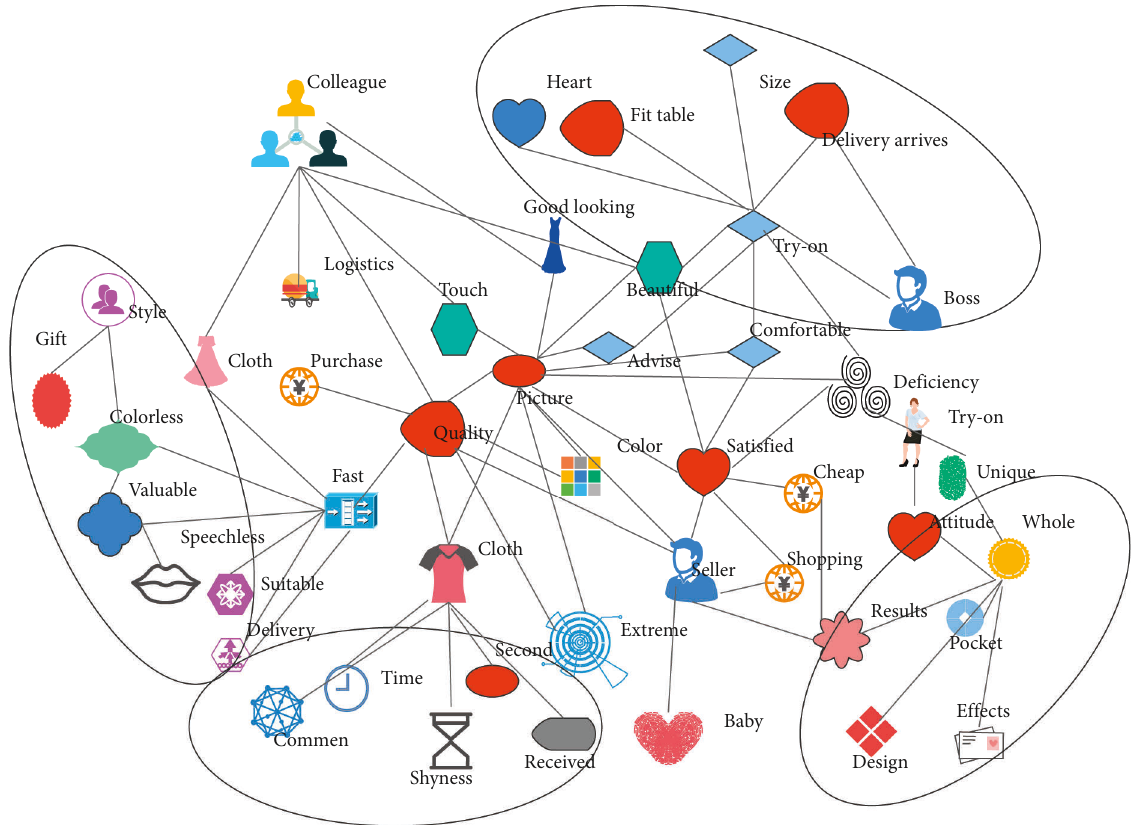
Figure 7: Semantic network structure of online shopping reviews.